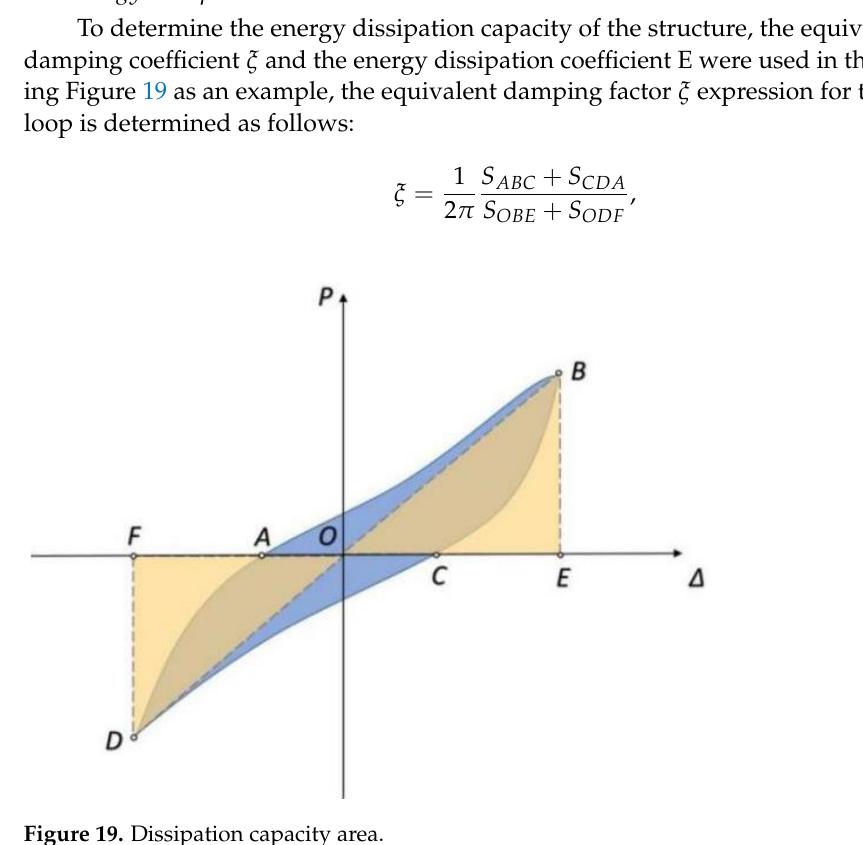
Figure 19. Dissipation capacity area. The energy dissipation capacity indexes of specimens SF-1 and SF-2 under ultimate load and damage conditions are shown in Table 6. The energy dissipation coefficient E for each level of cyclic loading is shown in Figure 20. Table 6. Factors associated with energy consumption for specimens SF-1 and SF-2.